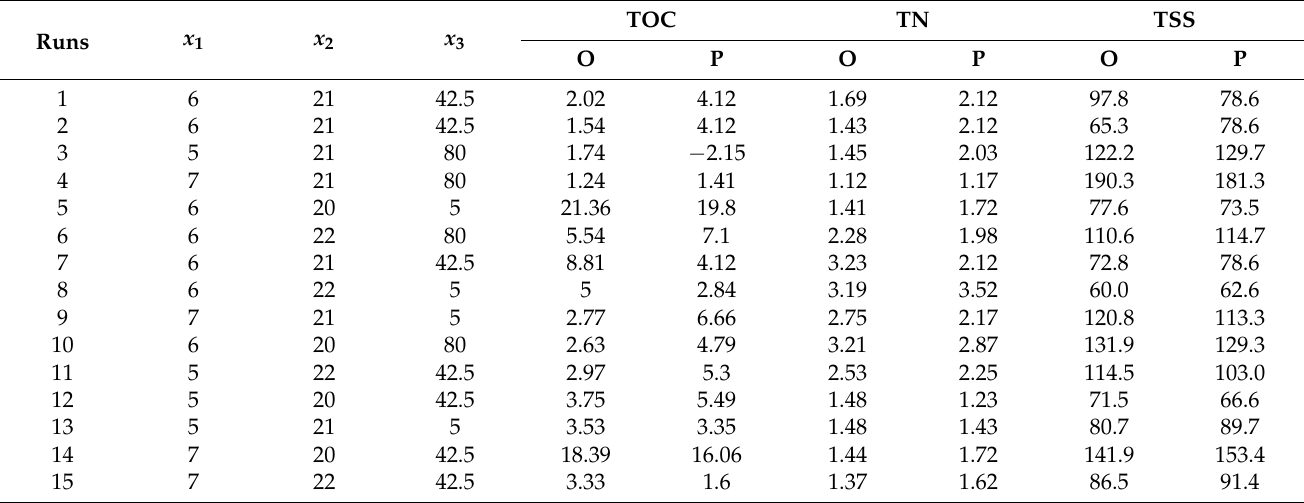
Table 3. Matrix of observed and predicted